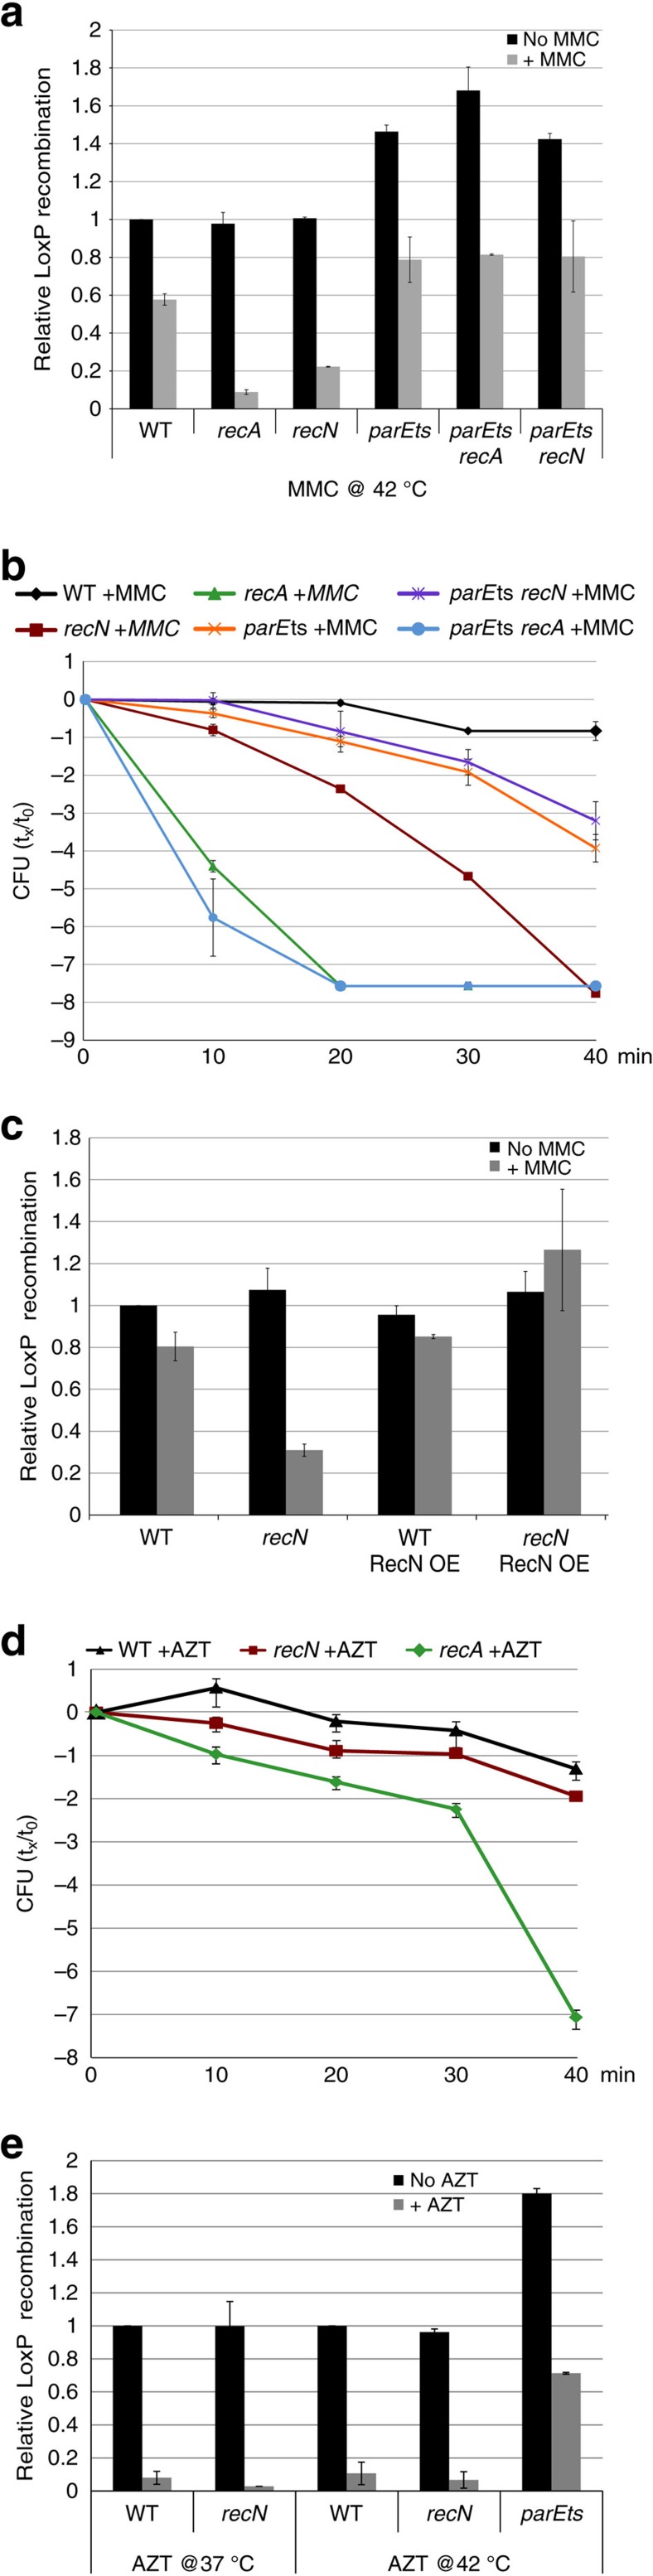
RecN-mediated SCIs are specifically established in response to DSBs.(a) Measurements of SCIs following Topo IV alteration in the presence of MMC. LoxP assays were performed at 10, 20, 30 and 40 min after the addition of MMC. The results at 30 min are presented; the results at 10, 20 and 40 min are presented in Supplementary Fig. 3. The results are expressed as the relative loxP recombination, with MMC normalized to untreated WT. Cells were incubated for 25 min at 42 °C before the addition of 0.1% arabinose and MMC. (b) Influence of Topo IV alteration on WT, recN and recA mutant viability in the presence of MMC. The cell viability assay was performed at non-permissive temperature of 42 °C. (c) Influence of RecN overexpression on SCIs. The plasmid pZA31 carries recN under the control of a leaky promoter. The results are expressed as the relative loxP recombination of the MMC-treated sample normalized to the untreated WT. (d) Viability of WT, recN and recA mutants in the presence of SS gaps formed by AZT. (e) Measurement of SCIs in the presence of SS gaps. LoxP assays were performed as described in A. Error bars are s.d. of four experiments.